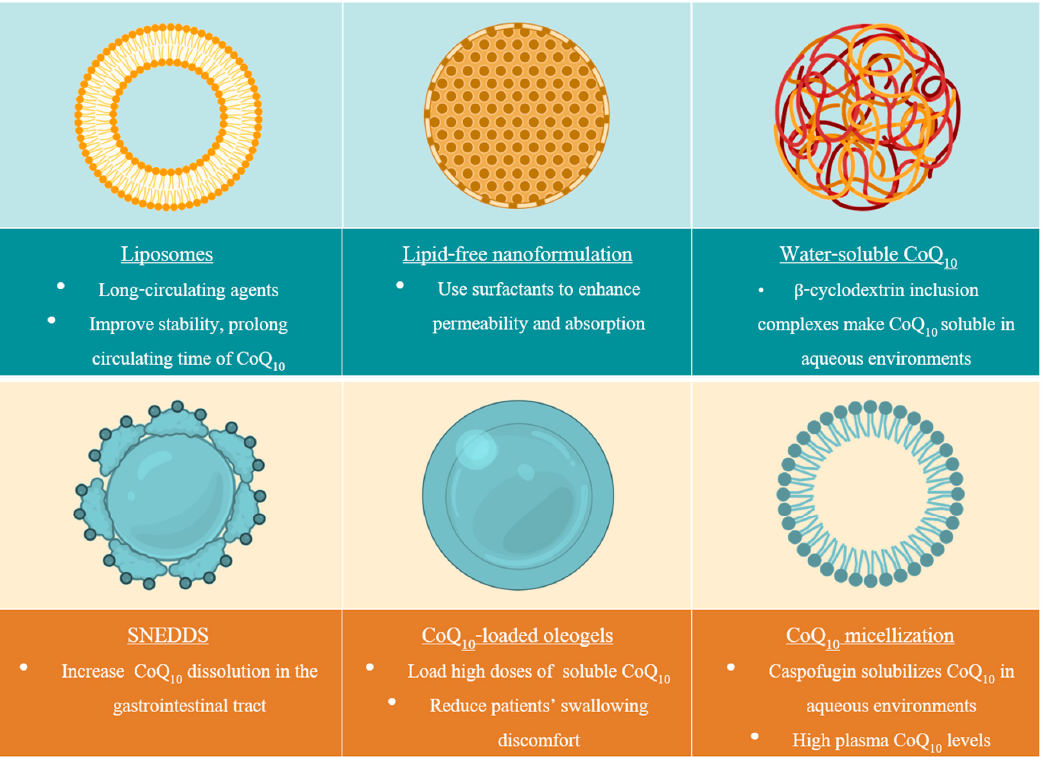
Figure 2. Highlights of CoQ 10 formulations. The initial trend in CoQ 10 formulations’ design was to use non-polar agents as delivery systems due to several advantages they present (increase drug solubility in intestines, recruit lymphatic drug transport, or modify enterocyte-based drug transport and disposition). However, there is rising interest in the development of water-soluble delivery mechanisms in order to prevent the common drawbacks of lipid-based formulations, such as rate of dispersion, degree of emulsification, particle size, or drug precipitation from the formulation upon dispersion. The first attempts towards this goal include the development of lipid-free CoQ 10 nanoformulations, micellar CoQ 10 solutions, and hydrophilic CoQ 10 inclusion